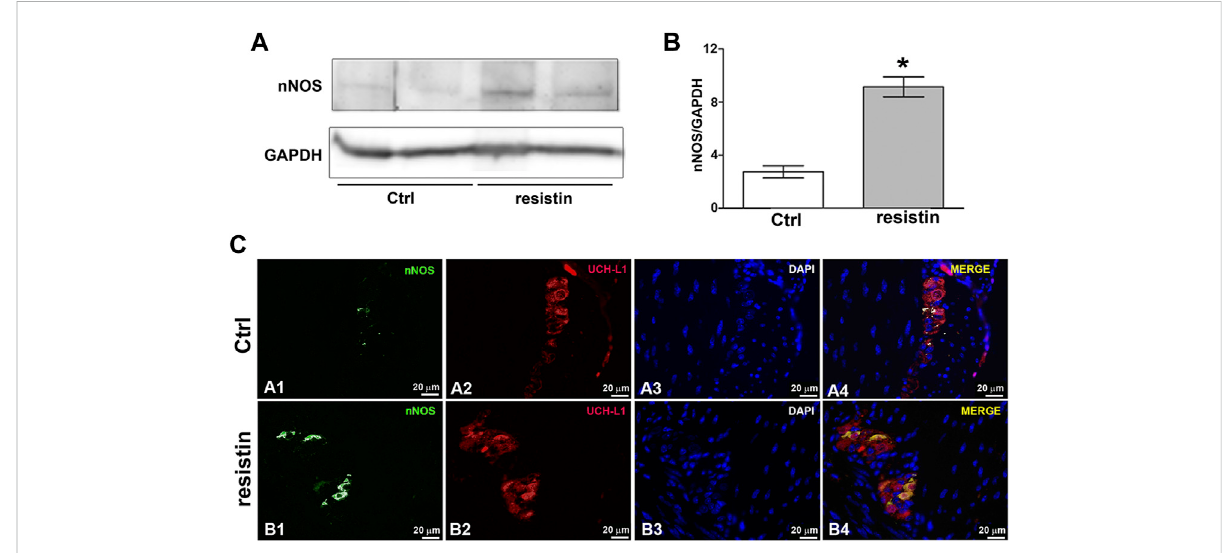
FIGURE 4 Resistin up-regulates nNOS expression. (A) Effect of resistin exposure (30 min) on nNOS expression in mouse gastric fundus assayed by Western blotting: representative bands from a typical experiment. The two representative lanes for control and resistin samples are biological replicates from separate animals. (B) Quantitative analysis. Columns are means ± SEM. Signi fi cance of differences (Student ’ s t-test for two independentsamplesfrom3mice):* p < 0.05 vs controls(Ctrl). (C) Representativephotomicrographsofgastrictissuefromcontrolandresistin- exposed (30 min) preparations showing double immuno fl uorescence labeling. (A1 – A4) Co-localization of nNOS and UCH-L1 in control mice: (A1) nNOS signal (green channel); (A2) UCH-L1 signal (red channel); (A3) DAPI; (A4) merged images. (B1 – B4) Co-localization of nNOS and UCH-L1 in resistin-exposed preparations: B1 nNOS signal (green channel); (B2) UCH-L1 signal (red channel); (B3) DAPI; (B4) merged images. Scale bar: 20 μ